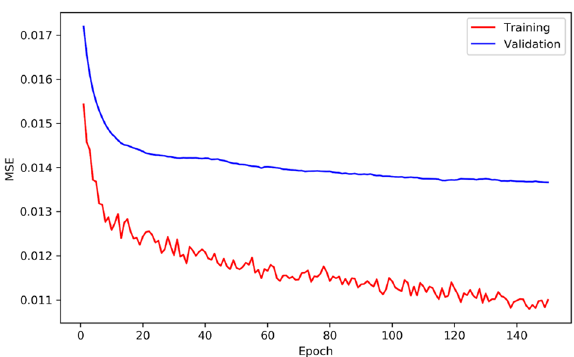
Fig. 5 AI learning process on OpenReview dataset. Mean Squared Error vs. number of training epochs for OpenReview training process, with batches of